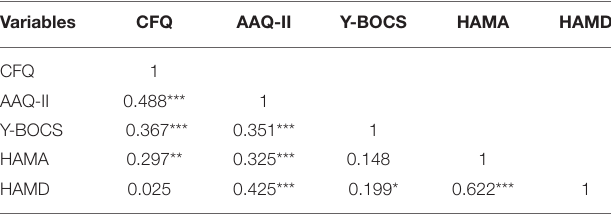
TABLE 3 | Correlation analysis results of obsessive–compulsive symptoms, anxiety, depression, cognitive fusion, and experiential avoidance ( n = 118, r ). Variables